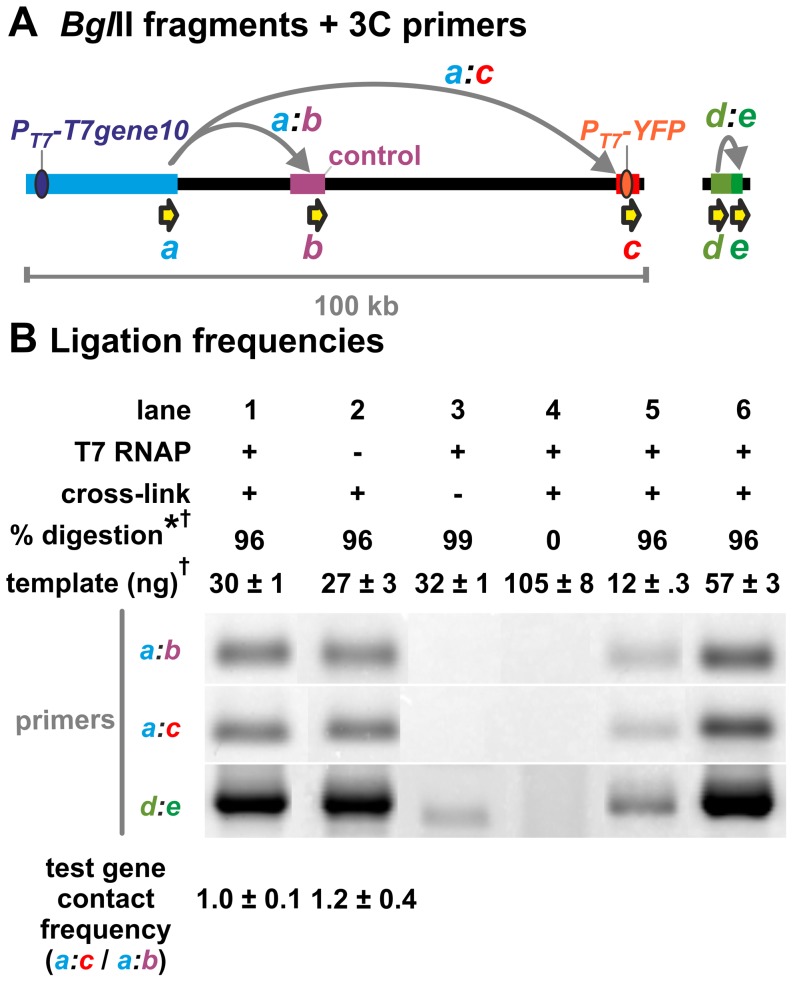
Genes transcribed by T7 RNAP do not interact in vivo.
A. Diagram of BglII fragments (thick coloured regions), PCR primers (yellow arrows) and ligation products (grey arrows) used in 3C. Ovals denote transcription units under the control of the T7 promoter. We determined the ligation frequency of the BglII fragment encoding PT7-T7gene10 (light blue; 24 kb) with (i) the 3-kb fragment encoding PT7-YFP located 80 kb away (orange; using primers a and c), and (ii) a 5-kb promoter-less control fragment 22 kb away (purple; using primers a and b). As a secondary control for 3C efficiency, we also measured the ligation frequency of two adjacent fragments located at a randomly-chosen genomic site (pink and green; using primers d and e). This genomic map is drawn to scale. B. 3C. The ‘3C strain’ in Fig. 3A was grown to OD600 = 0.4 in arabinose (+T7 RNAP) or glucose (−T7 RNAP), 3C templates prepared using BglII, and ligation products detected by PCR using the primer pairs indicated. Images show PCR products resolved on an agarose gel, and stained with SYBR green I. Loading controls (lanes 5–6) show that band intensities are proportional to the amount of ligation product present in the preceding PCR reactions, and thus to the contact frequency of the selected restriction fragments. All PCR products are of the expected size, and depend upon formaldehyde crosslinking (lane 3) and restriction nuclease digestion (lane 4). For each condition, the ‘test gene contact frequency’ (of T7gene10 with YFP) was calculated by dividing the intensity of the band produced by the primers a:c by the intensity of the band produced by primers a:b. This adjustment corrected for differences in 3C efficiency, and so allowed ligation frequencies obtained from different samples (i.e., ± T7 RNAP) to be directly compared. Transcription of T7gene10 and YFP by T7 RNAP had no effect on their contact frequency (compare test gene contact frequencies in lanes 1 and 2). Normalizing for 3C efficiency using the ligation frequency of the adjacent fragments (i.e., a:c/d:e) yielded the same result (1.9±0.6 a.u. for +T7 vs. 2.7±0.2 a.u. for −T7). a.u. = arbitrary units. *all measurements had standard deviations of less than 1% (n = 3). †assessed by qPCR.